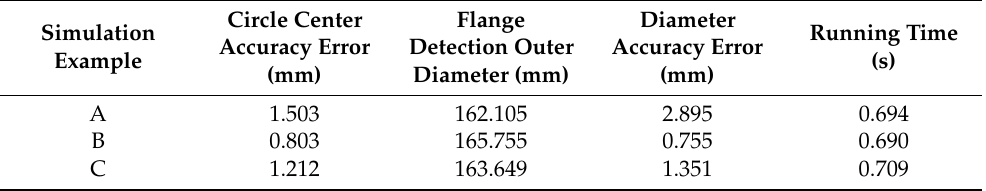
Table 2. On-site flange detection